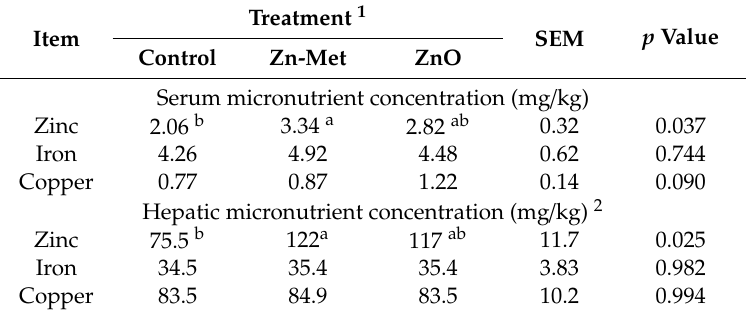
Table 4. E ff ects of Zn-Met and ZnO on the serum and tissue micronutrient concentrations of Holstein dairy calves.